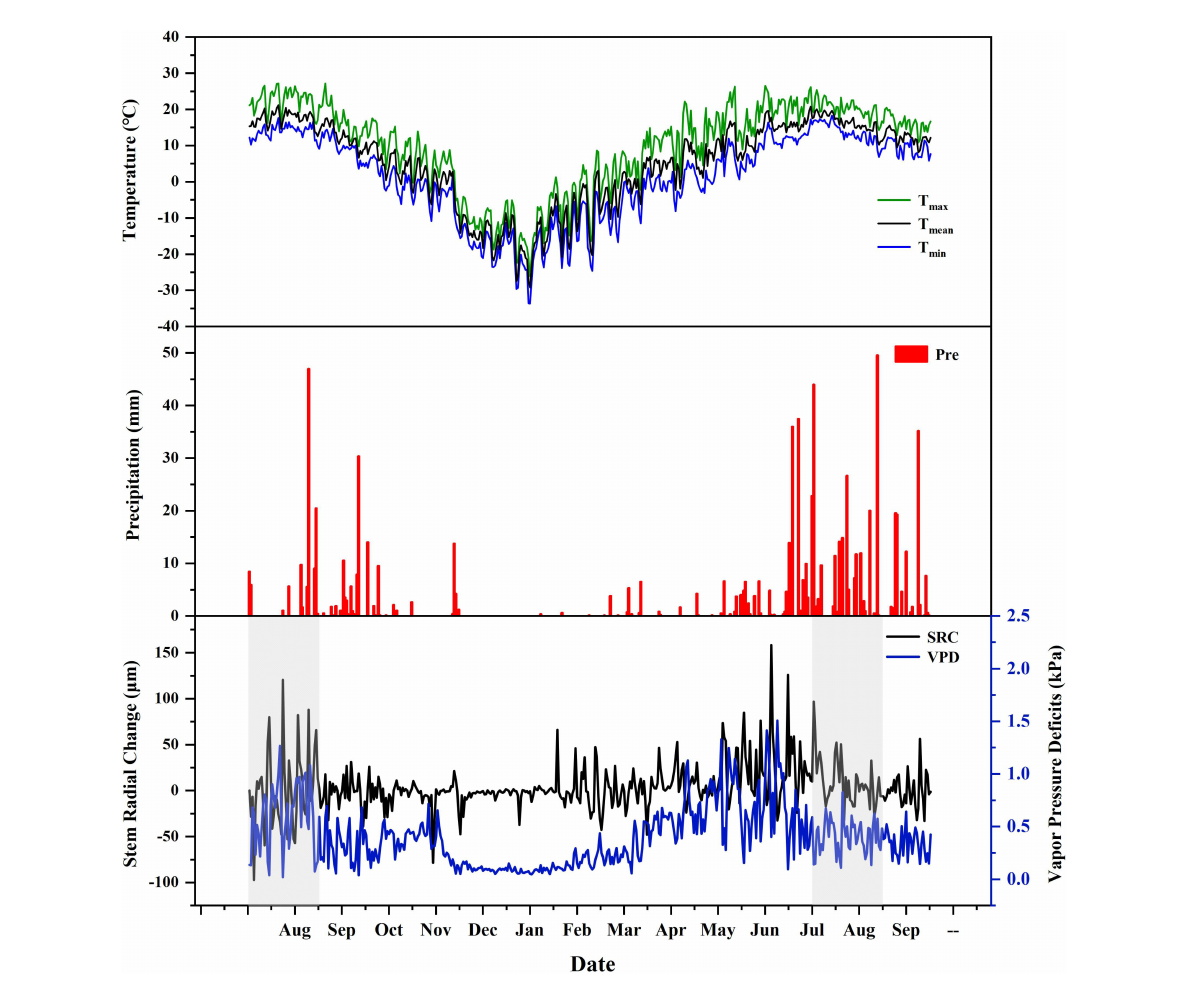
FIGURE5 Daily climatic conditions at the meteorological stations in WeiChang station during the monitoring period from July 2020 to September 2021. From top to bottom: daily minimum (blue), average (black), and maximum (green) temperature; precipitation (red); changes in stem radial change (black line: SRC) of mean trees and vapor pressure deficits (blue line: VPD). The shaded part is the comparison of SRC and VPD in the same period in 2